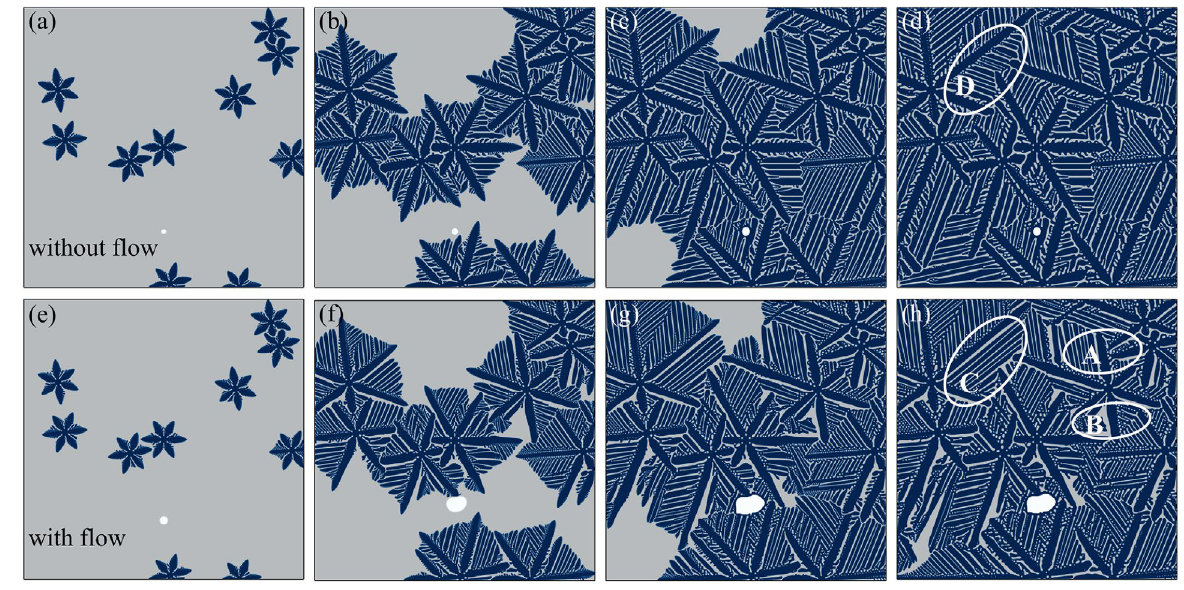
Figure 5. Evolution of polycrystalline and hydrogen bubble. ( a – d ) are the simulation results without flow, and ( e – h ) are the simulation results with flow. The time of these snapshots is 27.32, 81.78, 136.25, and 217.95 units of τ 0 from left to right [82].